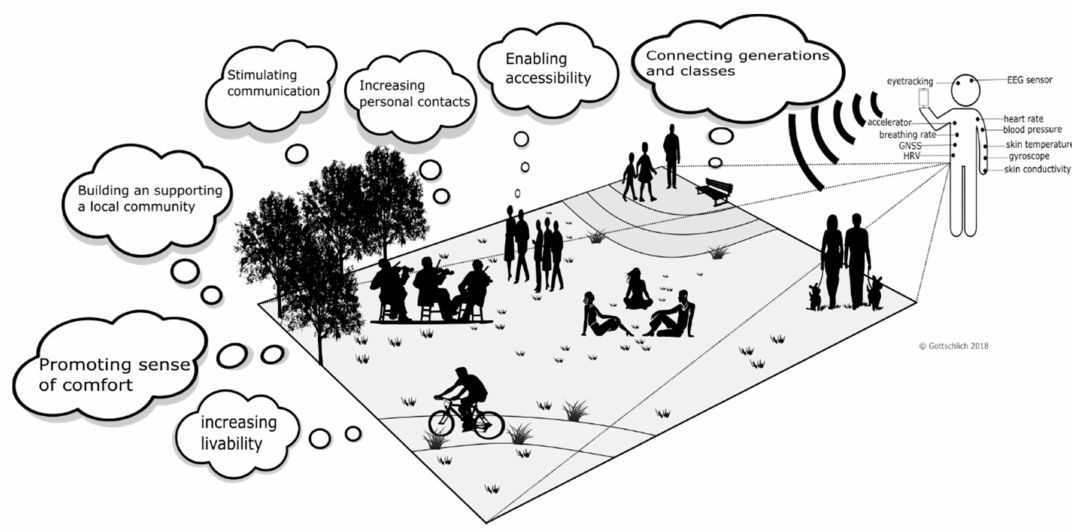
Figure 4. Placemaking: A concept that calls for a place-based GIS